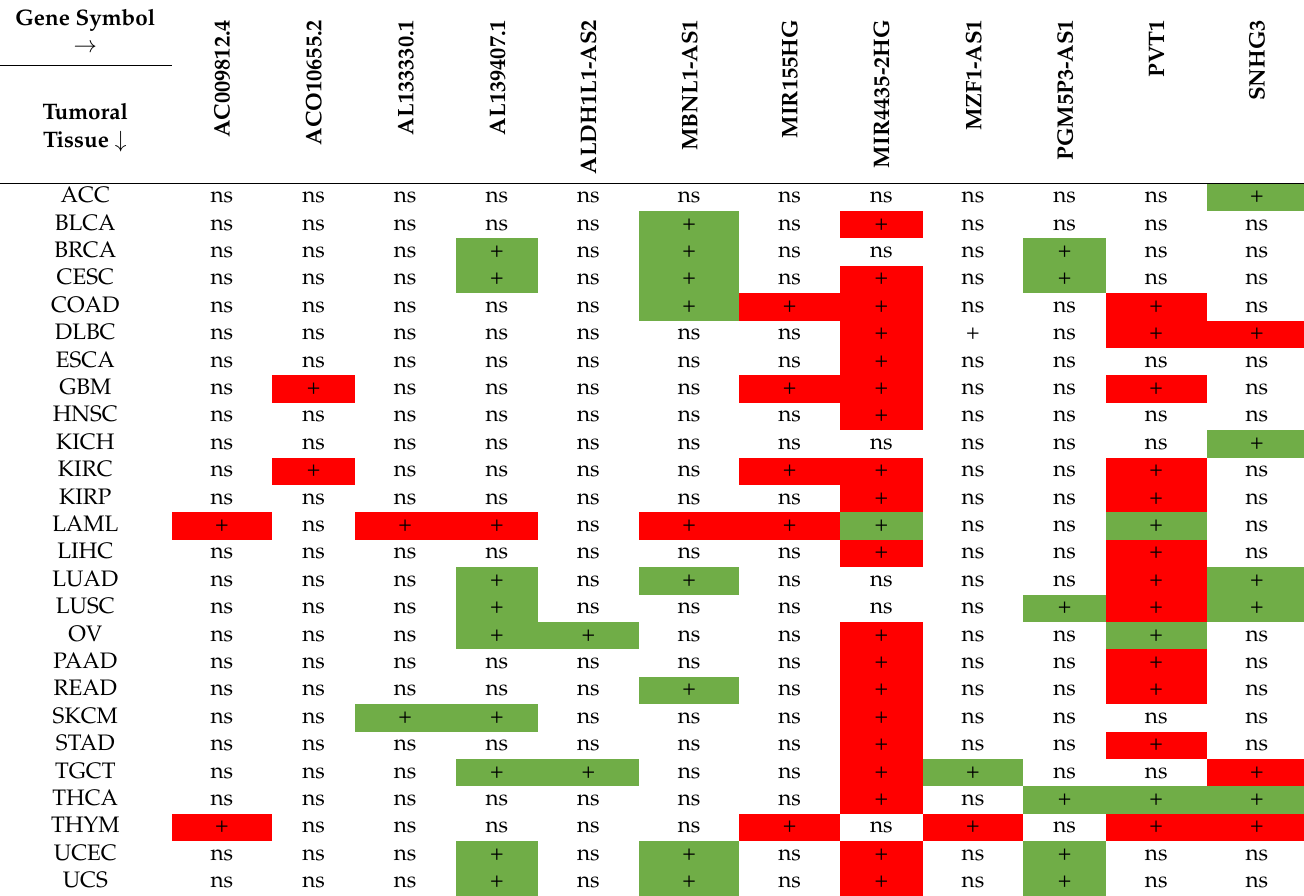
Table 4. Correlation of lncRNAs with expression in cancer. Deregulation has been investigated in tumoral versus healthy tissue using GEPIA2 database and reported as ns (non-significant deregulation), a green + (upregulation in normal tissue) and a red + (upregulation in tumoral tissue). ACC: Adrenocortical carcinoma; BLCA: Bladder urothelial carcinoma; BRCA: Breast invasive carcinoma; CESC: Cervical squamous cell carcinoma and endocervical adenocarcinoma; COAD: Colon adenocarcinoma; DLBC: Lymphoid neoplasm diffuse large B-cell lymphoma; ESCA: Esophageal Carcinoma; GBM: Glioblas-